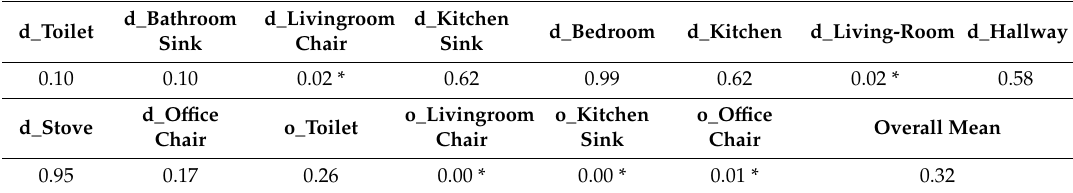
Table 7. One-way ANOVA results for between-group behavior comparisons. Entries in blue indicate the duration in a location, and entries in green indicate the activity level in a location. (* = Result is statistically significant ( p < 0.05).).